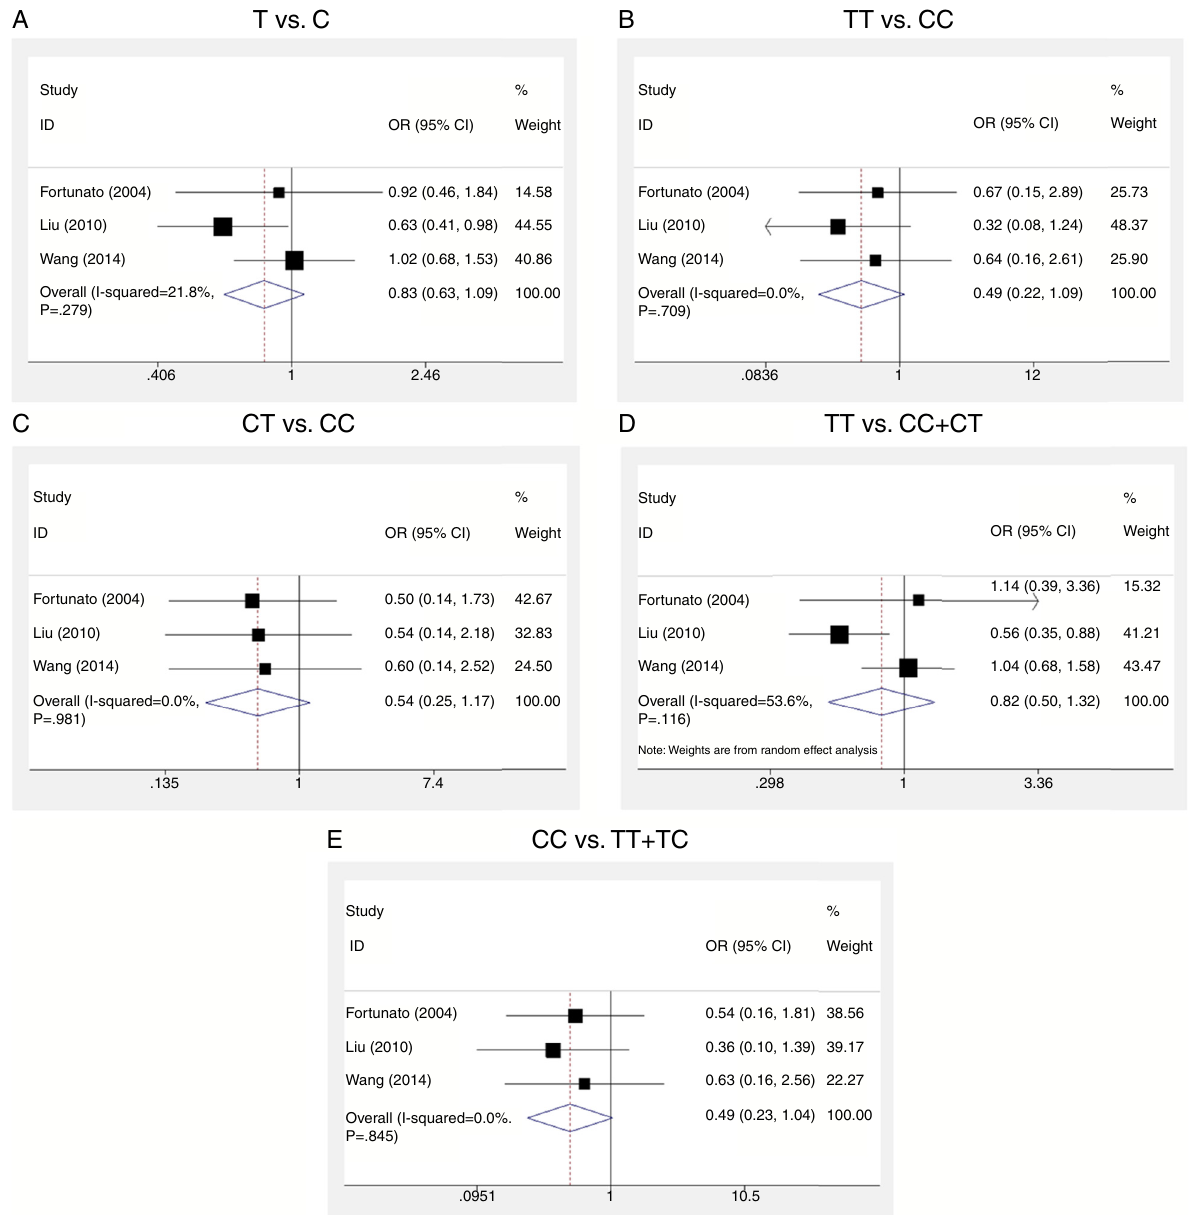
Forest plots regarding the association between superoxide dismutase 2 (SOD2) C47T polymorphism and noise induced hearing loss (NIHL) under all the genetic models using fixed effects or random effects models. Allele model, T vs . C (A); co-dominant model, TT vs . CC (B); CT vs . CC (C); recessive model, TT vs . CC + CT (D); dominant model, CC vs . TT + TC (E). CI, confidence interval; OR, odds